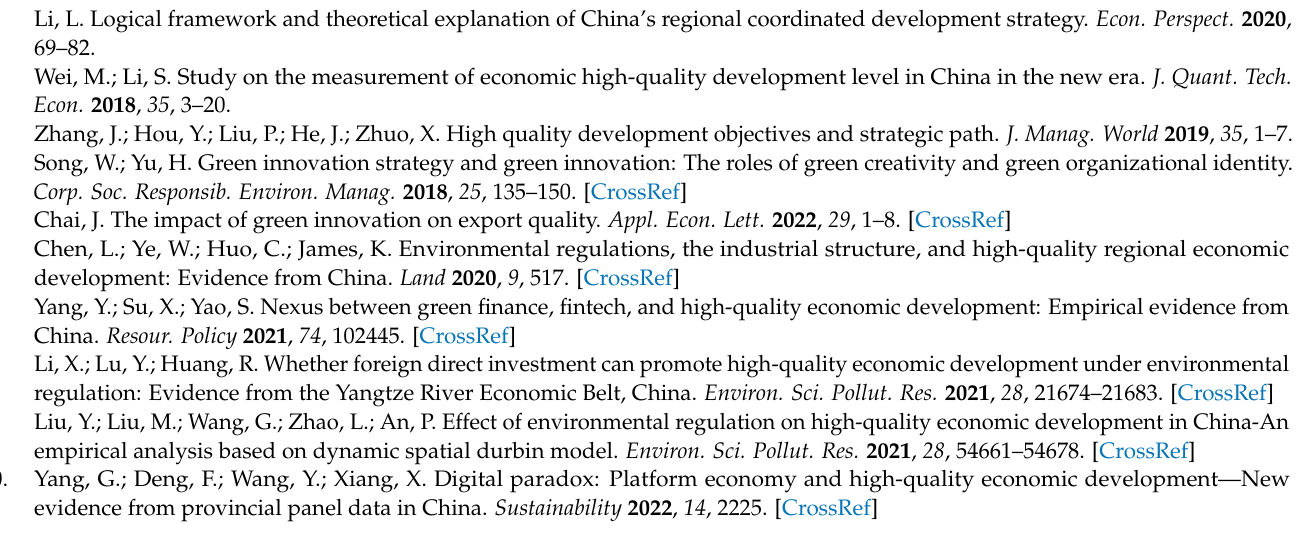
Figure A2. Geographical distribution of HQCD in 2019.